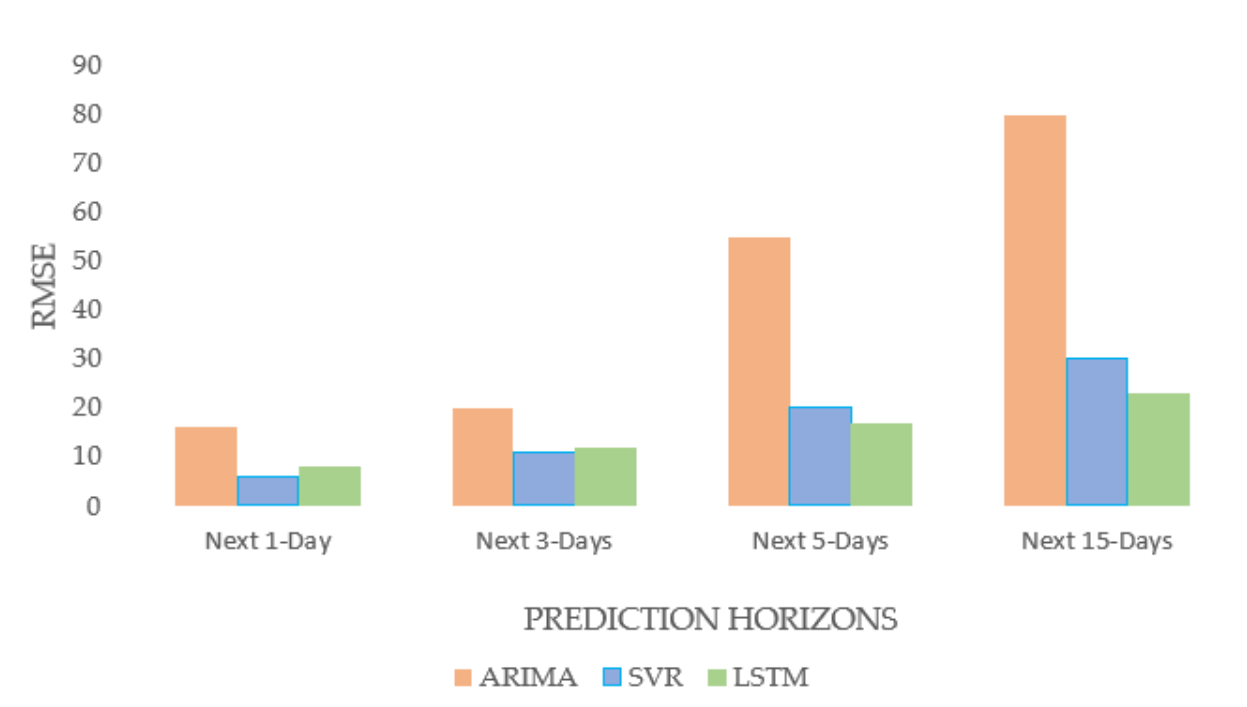
Figure 16. Comparison between ARIMA, SVR, and LSTM models.